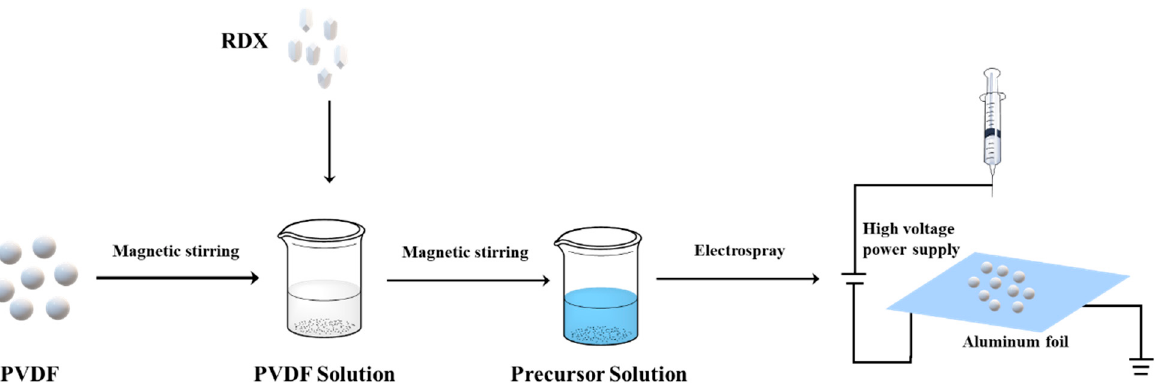
Figure 1. Scheme of preparation of RDX@PVDF microspheres employed by electrospray technol-